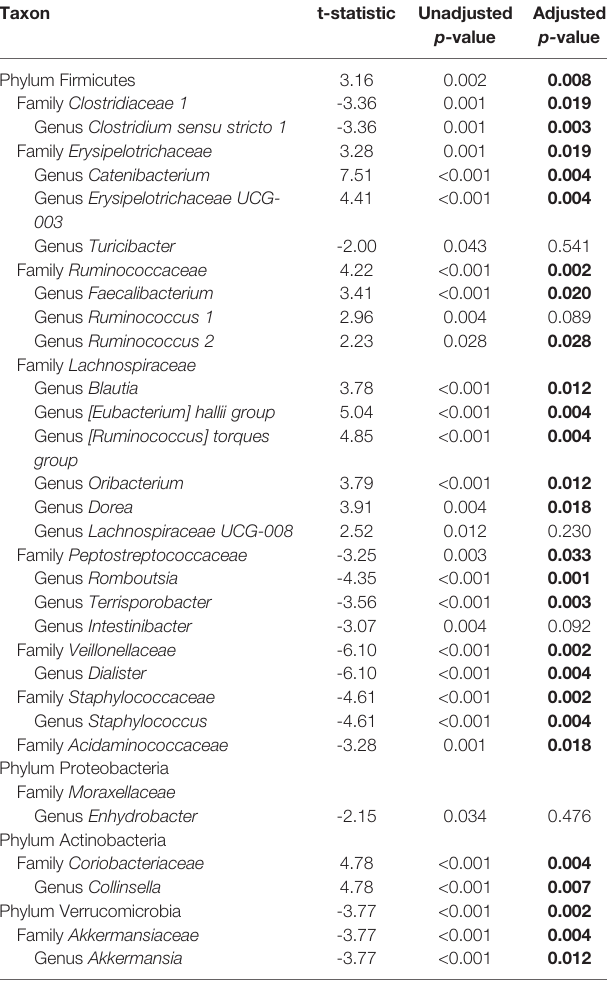
The change of column (log2 fold) represents the multiplicative change in taxa abundance from CRC to control. Negative numbers represent a trend of decreasing abundance in CRC group compared with control group. The data (p < 0.05) was provied as bold